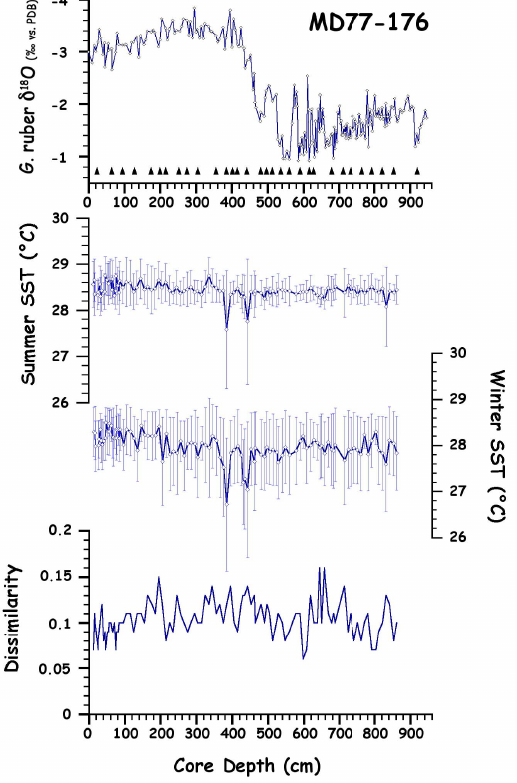
Fig. 2. Depth-age plots for core MD77-176. From top to bottom: δ 18 O of G. ruber , reconstructions of summer sea surface tempera- tures (SST) and winter SST with error bars and dissimilarity coeffi- cients between fossil assemblages and the modern